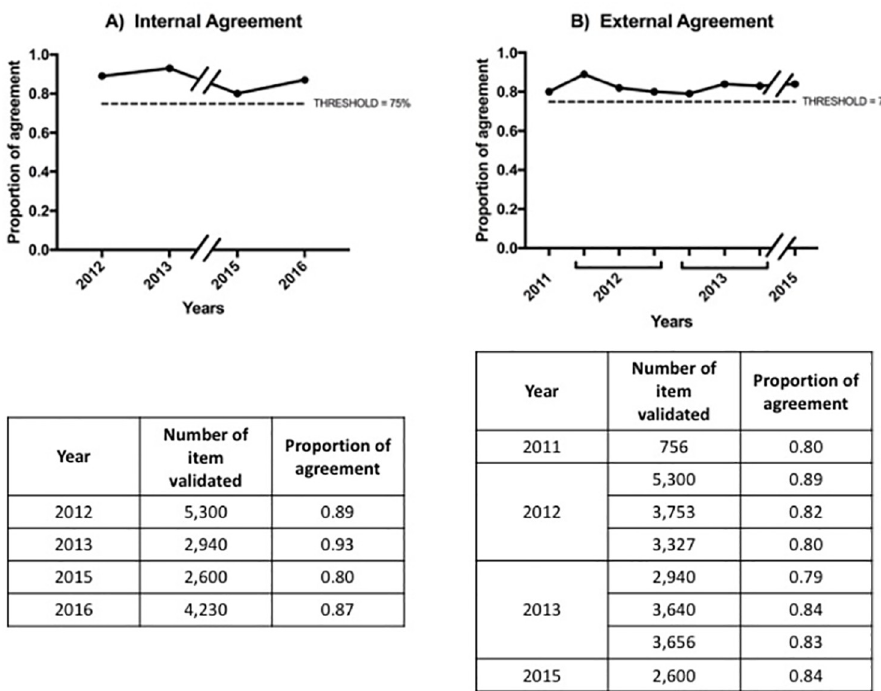
Clinical record is the main communication tool used by HCWs to ensure safe continuity of care. As primary source of written evidence of the care provided to patients, CR is the best source in order to evaluate quality and appropriateness of care in clinical governance [6]. With